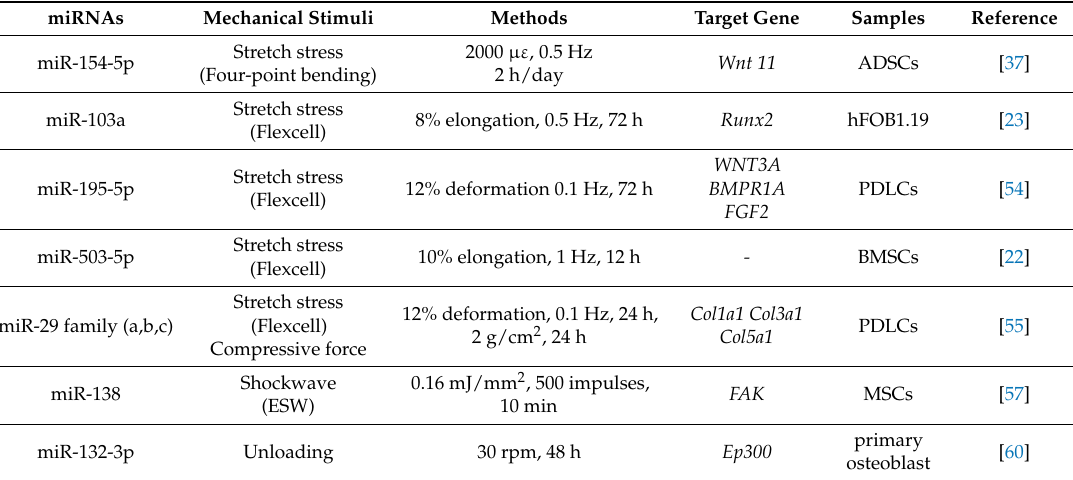
Table 3. Mechanosensitive miRNAs inhibit osteogenic